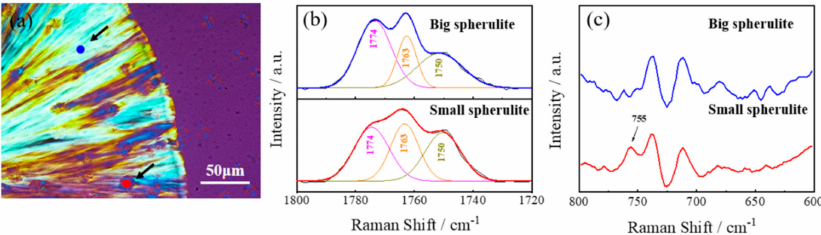
Figure 4. ( a ) Certain areas of the big (blue dot) and small spherulites (red dot) in the PLLA / 4-C-D1.5 blend. ( b ) Raman spectra in the range of 1720–1800 cm − 1 and the peak-fitting result within the ν C = O region. ( c ) Raman spectra in the range of 600–800 cm − 1